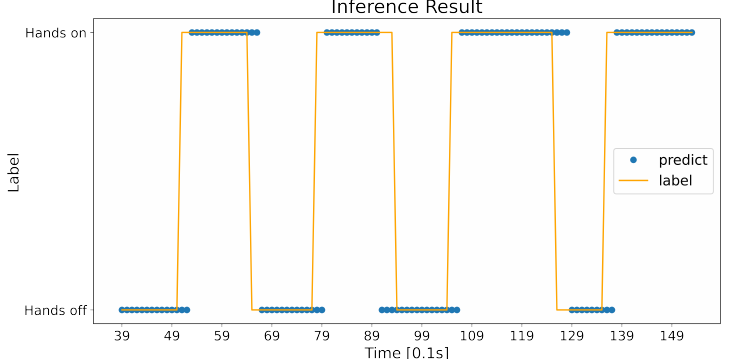
Figure 7. Predictions of a network with a confidence logic.